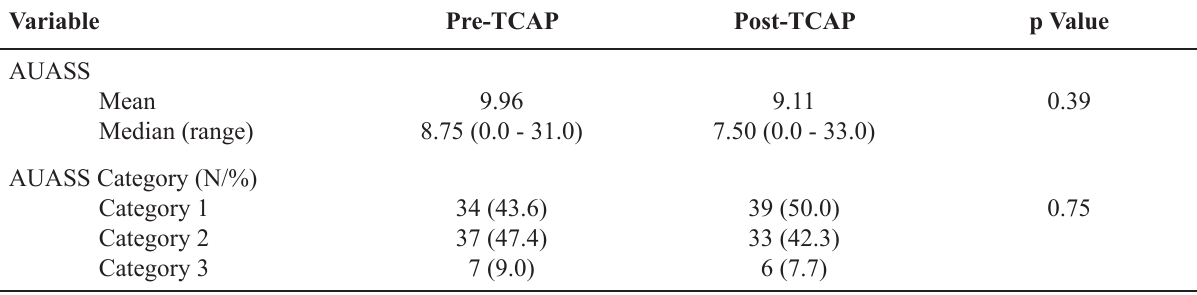
Table 3 – Analysis of pre- and post- targeted cryoablation of the prostate (TCAP) American Urologic Association Symptom Score (AUASS).